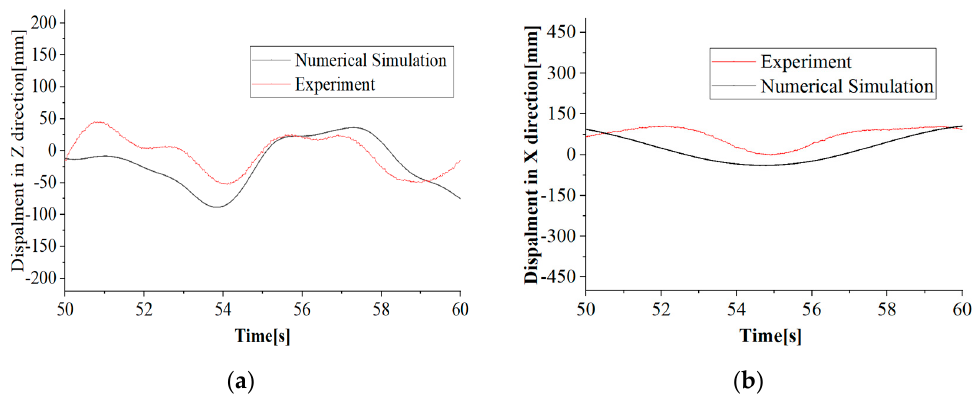
Figure 34. Comparison between numerical simulation and experiment at LC1. ( a ) Heave; ( b ) surge.